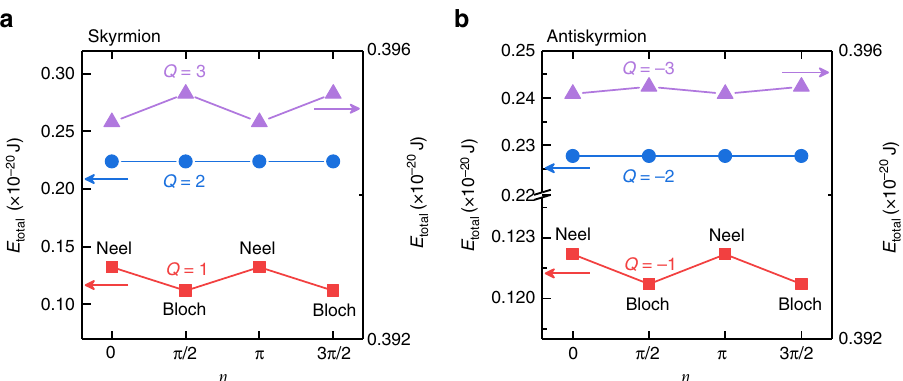
Fig. 4 Total micromagnetic energy E total for a relaxed skyrmions and b relaxed antiskyrmions as functions of Q and η . The lowest energy states are found to be two degenerate Bloch-type states both for the skyrmion ( Q = 1) and the antiskyrmion ( Q = − 1) due to the DDI. The corresponding spin con fi gurations for relaxed skyrmions and antiskyrmions are given in Fig. 2 and Supplementary Fig. 12, respectively